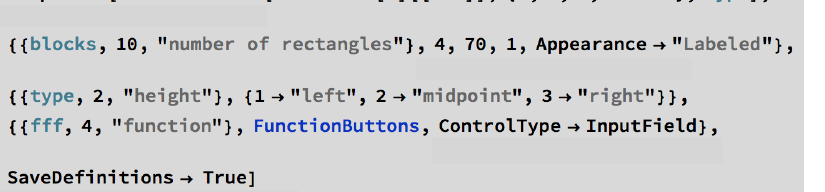
Figure 1. Part of the code of the tool “Riemann Sums”, used in the examples presented in Figures 7 and